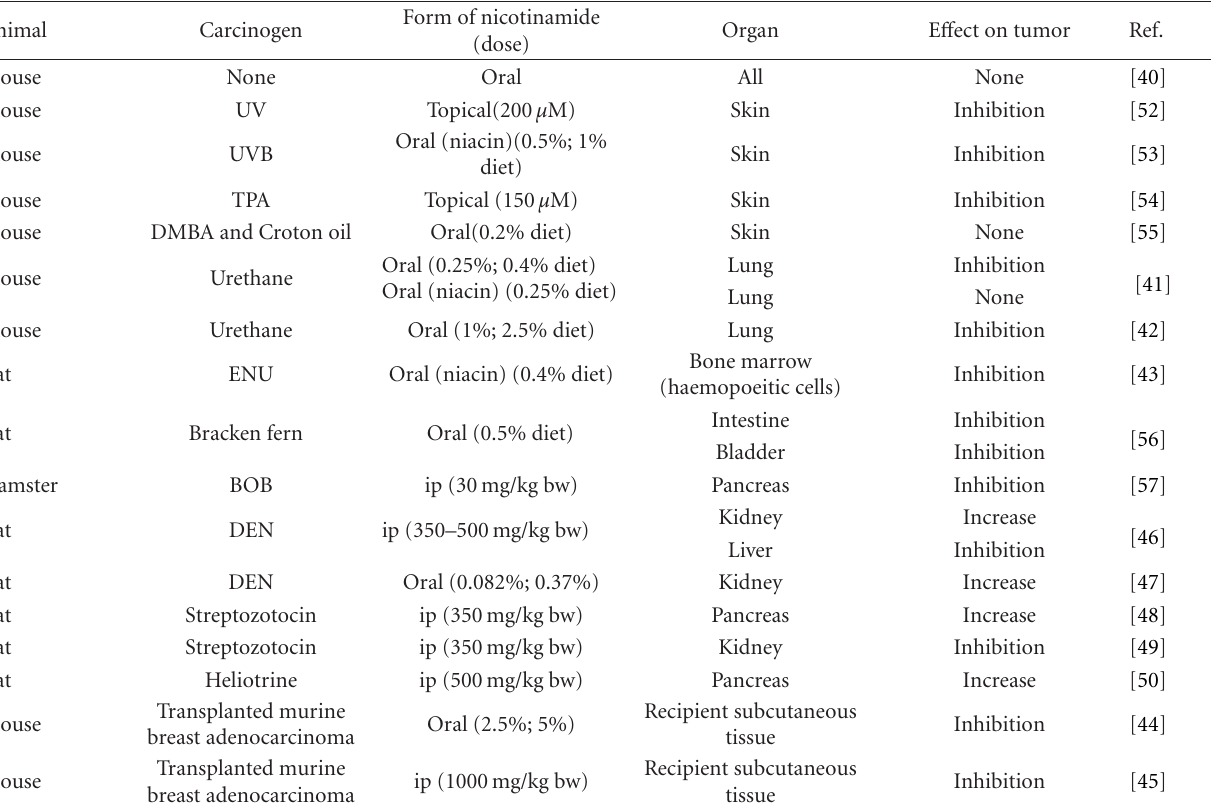
Table 1: Animal models of nicotinamide or niacin e ff ect on carcinogenesis. Form of nicotinamide Animal Carcinogen Organ E ff ect on tumor (dose)